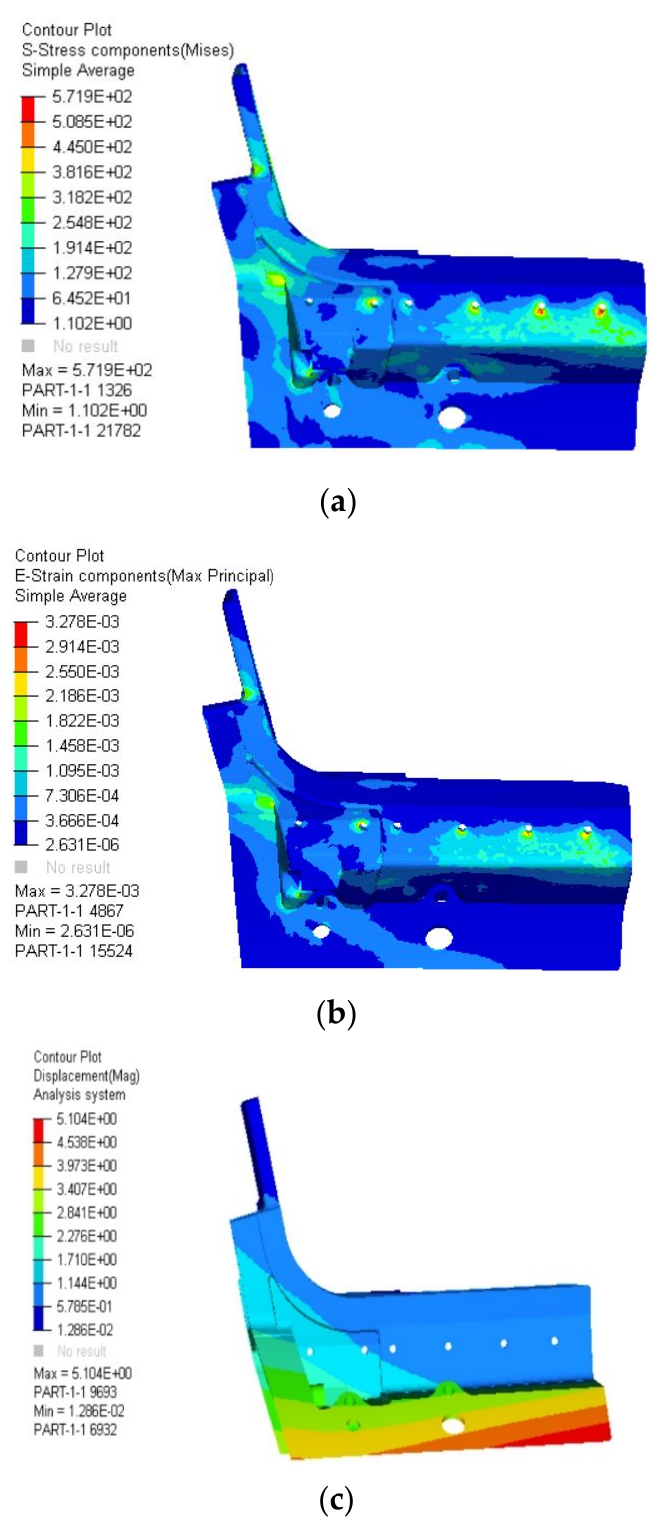
Figure 6. ( a ) Stress result; ( b ) Strain result; ( c ) Displacement result.